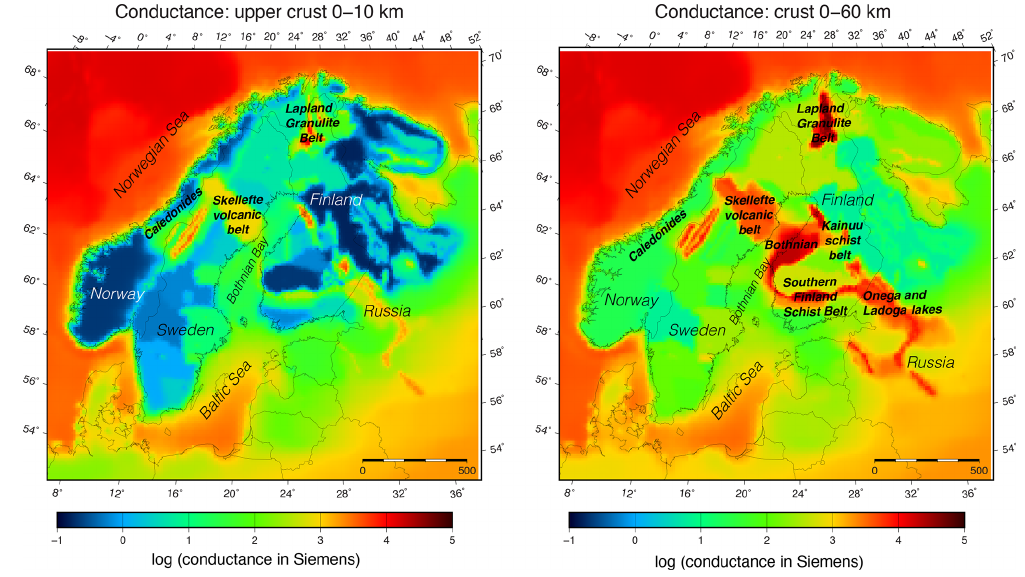
Figure 1. Conductance of the upper crust (0–10km) and crust (0–60km) based on S-map data (Korja et al.,